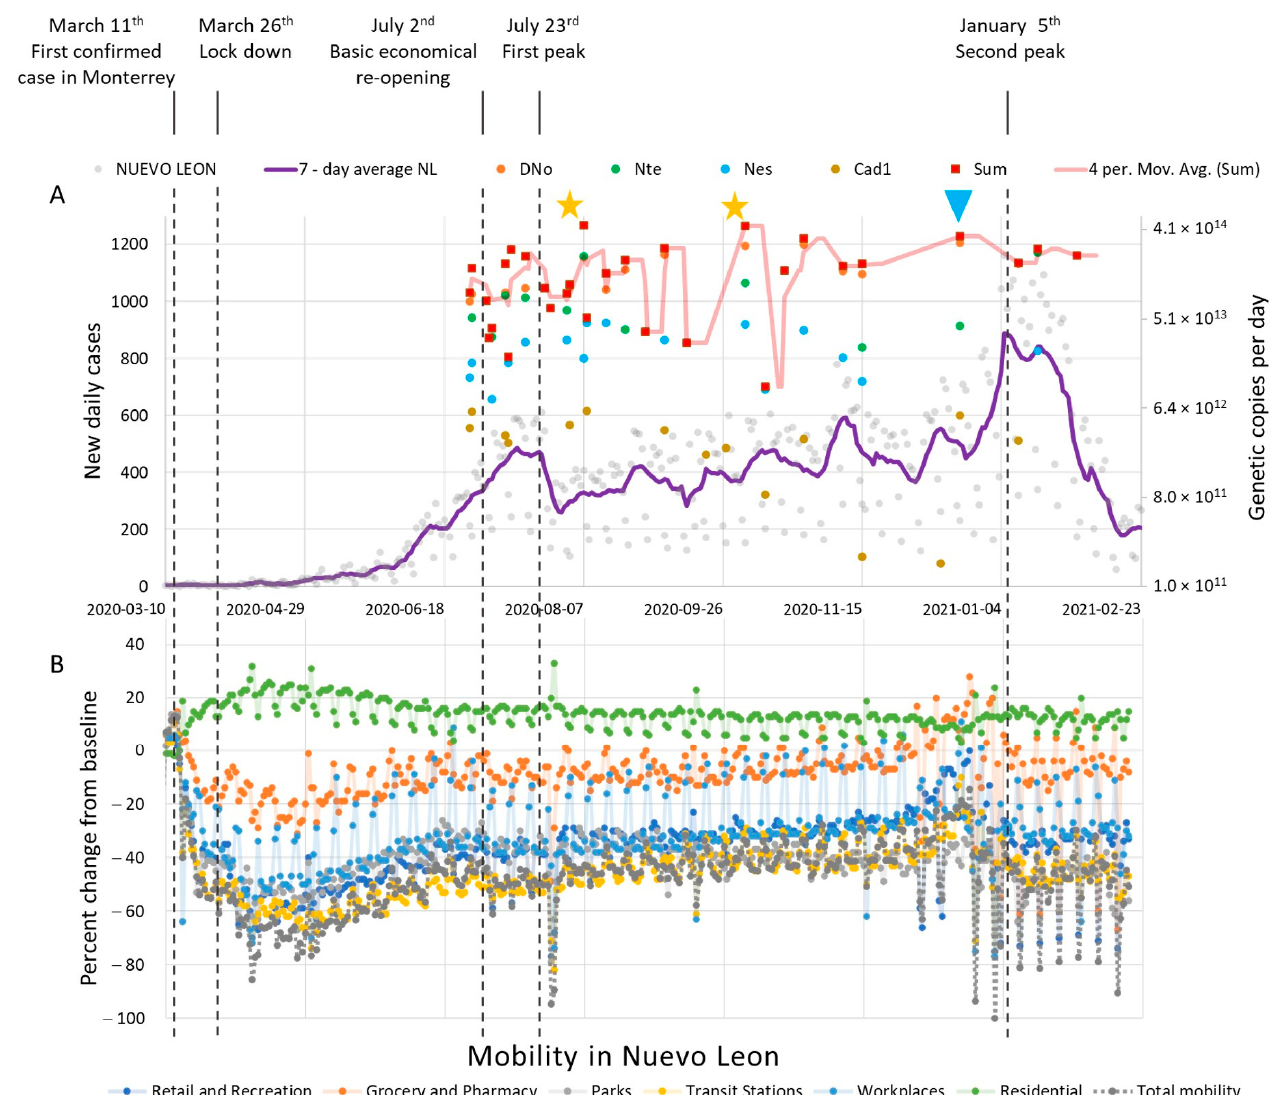
Figure 2. Wastewater monitoring ( A ) and mobility ( B ). The first graph ( A ) shows the official new COVID-19 cases per day (light gray circles) and its seven-day moving window average (purple continuous line) in Nuevo Leon state, México. The data were obtained from COVID-19 México from https://datos.covid-19.conacyt.mx/#DownZCSV (accessed on 16 September 2021) [34], along with the genome copies per day sum for all WWTPs in red squares with a four-day moving window average shown by a light red line. At the top, important events are highlighted with gray dashed lines, where two yellow stars mark the higher quantifications and an inverted blue triangle marks the higher quantification before the second wave peak. ( B ) Mobility reports from Nuevo Leon reported by the Google platform are plotted in the same time frame. The mobility report was separated into the following categories: retail and recreation, grocery and pharmacy, workplaces, residential, and total mobility. Each category was based on the time spent per day in each location type. This information was compared with the new cases and WBE information corresponding to the Monterrey metropolitan area since more than 80% of the population of Nuevo León was located in this area.